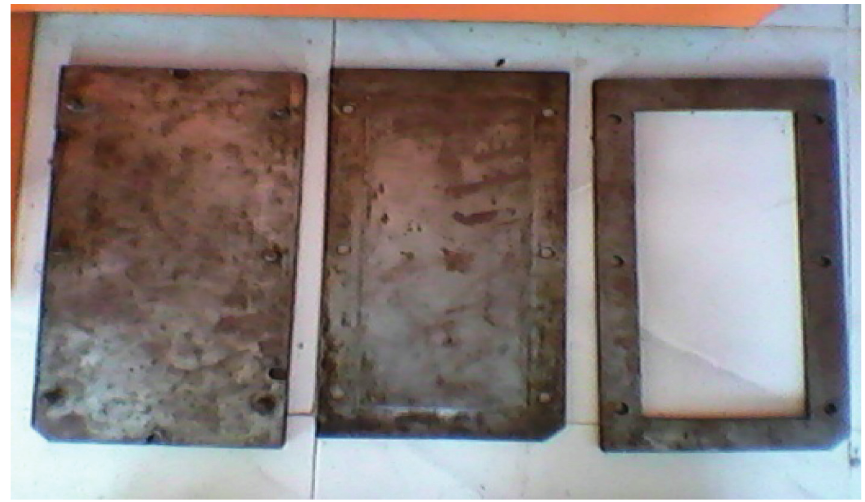
Figure 7: Steel die mold.